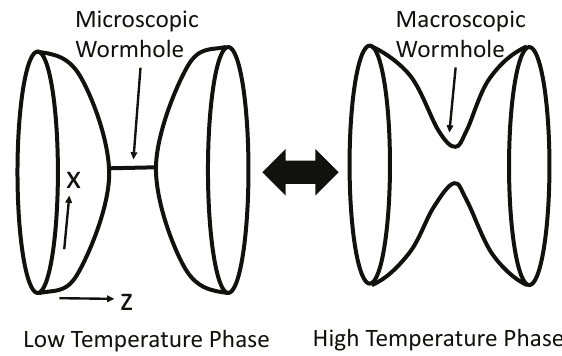
Figure 10 . The expected description of con(cid:12)nement/decon(cid:12)nement phase transition in our op- timization of path-integral for the TFD states. At low temperature the two CFTs are connected through a microscopic bridge with entanglement entropy O (1) in the tensor network. At high temperature the bridge gets macroscopic and has entanglement entropy O ( c